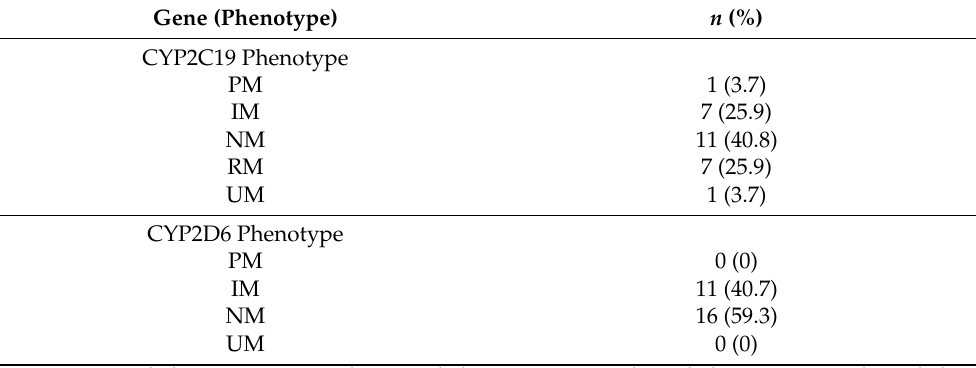
Table 3. Assigned likely patient CYP2C19 and CYP2D6